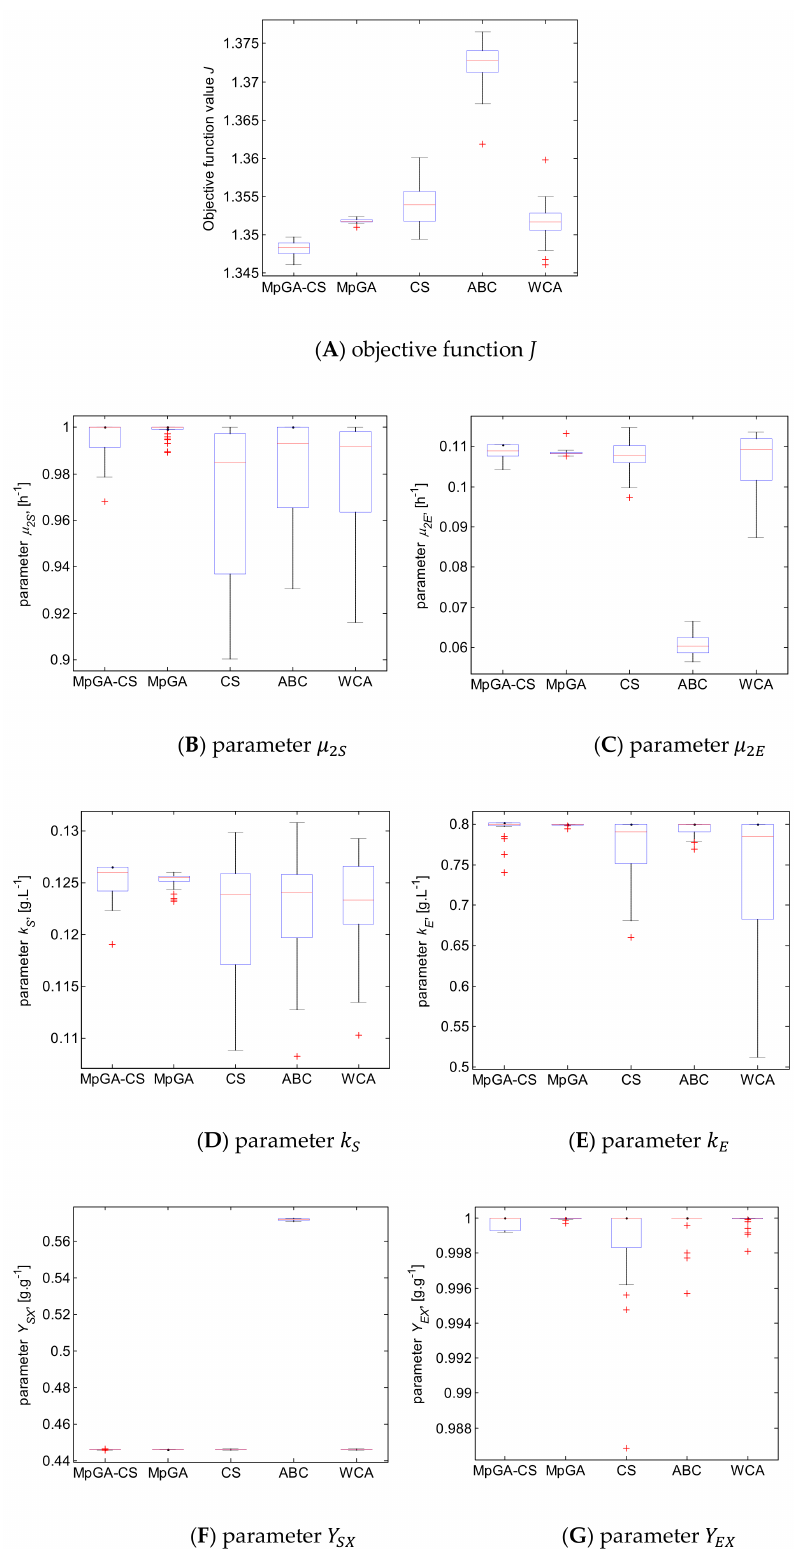
Figure 8. Box plot for the results from parameter identification of S. cerevisiae FP model. In analogy with the case of E. coli FP, the performance of MpGA-CS hybrid is again compared with the performance of CS, MpGA, ABC, and WCA based on the aforemen- tioned statistical tests. The results are presented in Table